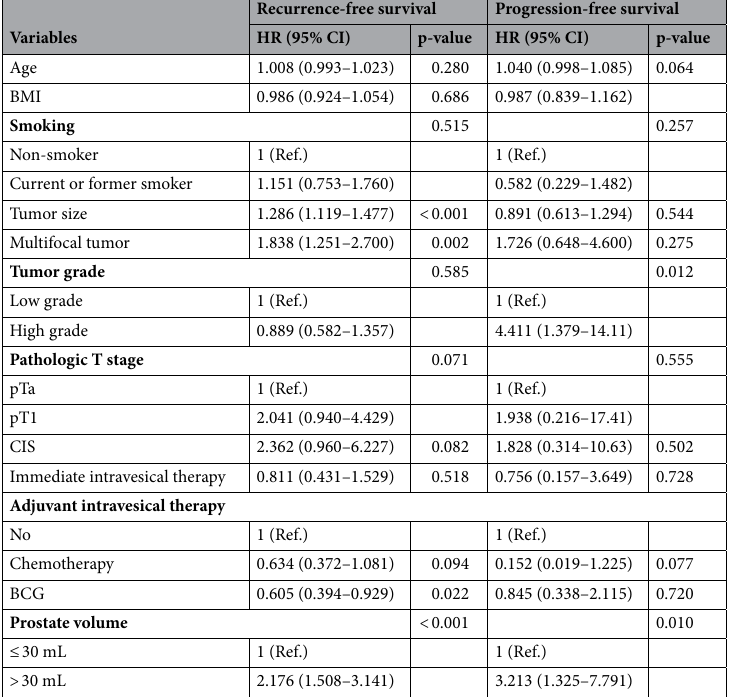
Table 2. Multivariable analyses of factors associated with recurrence-free survival and progression-free survival with all cohort. HR hazard ratio, BMI body mass index, CIS carcinoma in situ, BCG bacillus Calmette–